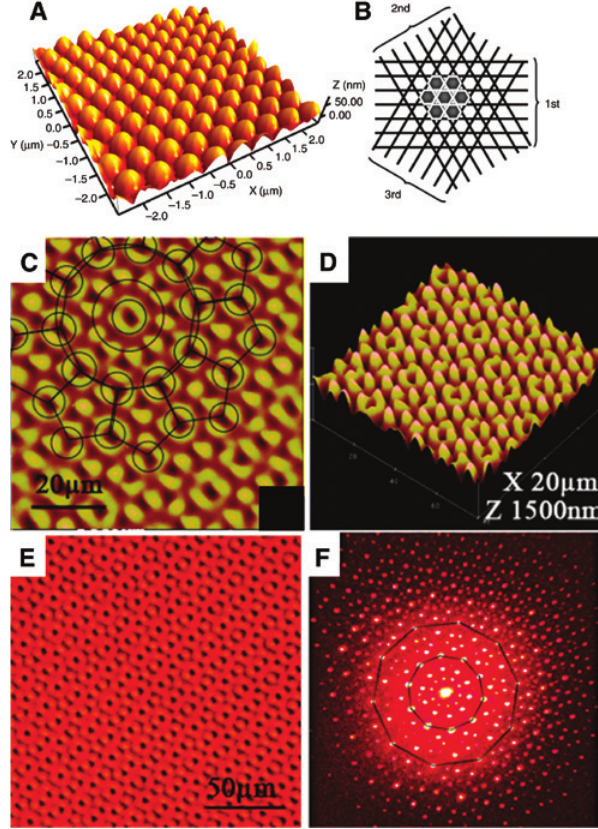
Figure 10: Complex SRGs from multi-step